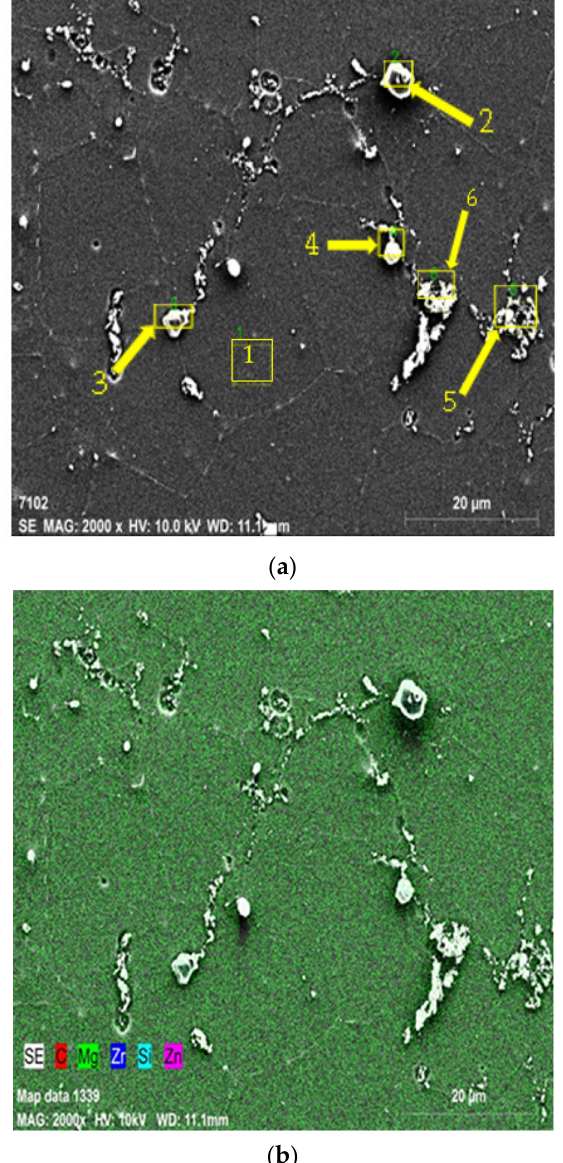
Figure 3. SEM microstructures of as ‐ extruded sample of ZK60 + 15% SiC; ( a ) the image EDX analysis in 2k× magnification (showing the six regions for examining with EDX spectral analysis); ( b ) the elemental mapping of the EDX image in Figure 3a. Table 3. The spectral analysis results of the regions in Figure 3a for ZK60 + 15% SiC.